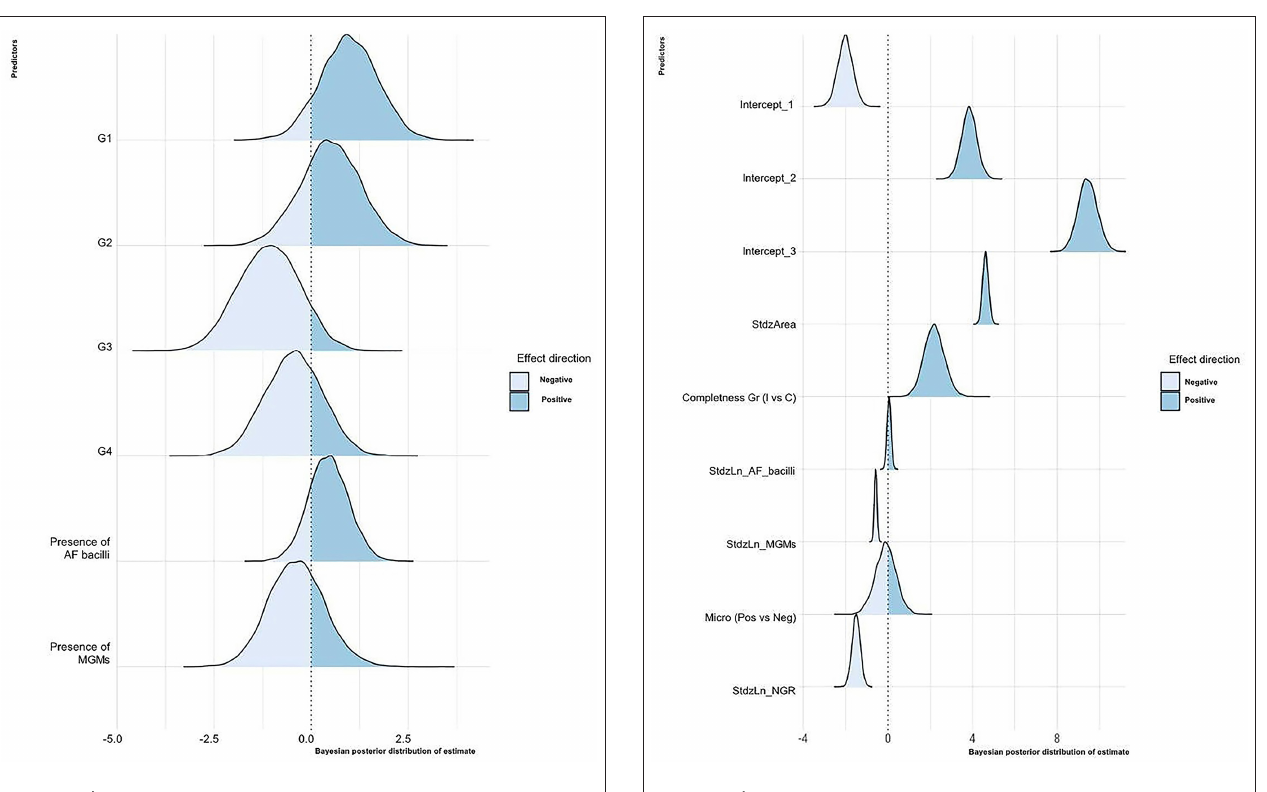
FIGURE 3 | Bayesian posterior distribution of estimated coefficients of the influence of the considered variables on the granuloma histological stage. For each predictor, the area corresponding to the values with a negative or a positive effect on the granuloma histological stage is shown. StdzArea, standardized log of the granuloma area; Completeness Gr, completeness of the granuloma into the section; I, granuloma incompletely depicted into the section; C, granuloma completely depicted into the section; StdzLn_AF_bacilli, standardized log of the number of AF bacilli per granuloma; StdzLn_MGMs, standardized log of the number of MGMs per granuloma; Micro, microbiological status of the LNs; StdzLn_NGR, standardized log of the number of granulomas per